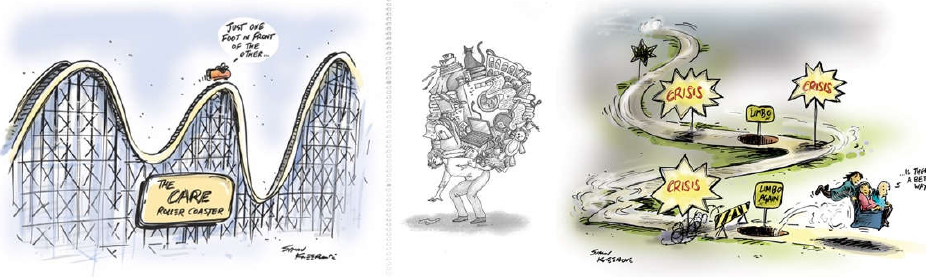
Figure 3. The care rollercoaster—lurching from crisis to crisis, carrying a heavy